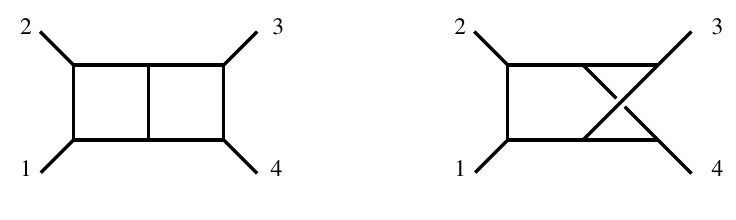
Figure 1 . Two-loop diagrams P and